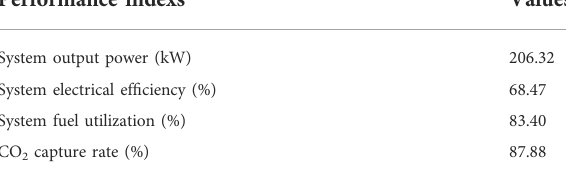
TABLE 4 Optimal operating parameters of the IGFC system. Performance